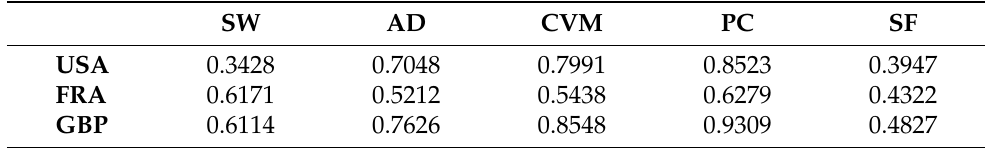
Table 2. Normality tests: We perform normality tests of the residuals (cid:98) ξ s using the Shapiro–Wilk (SW) test, Anderson–Darling statistics (AD), the Cramér-von Mises test (CVM), Pearson- χ 2 (PC) test, and the Shapiro–Francia (CF) test. The table shows the p values of the